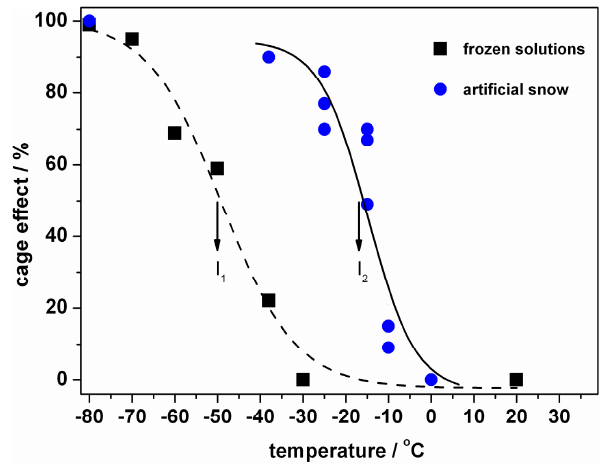
Fig. 4. The cage effect, determined for frozen and artificial snow samples. The inflection points (I 1 and I 2 ) are the temperatures Figure 4 . The cage effect, determined for frozen and artificial snow samples. The 1130 at which the rates of radical diffusion and recombination become inflection points (I 1 and I 2 ) are the temperatures at which the rates of radical diffusion and 1131 equal (Ruzicka et al., 2005; Kurkova et al., recombination become equal (Ruzicka et al., 2005; Kurkova et al., 2011). 1132